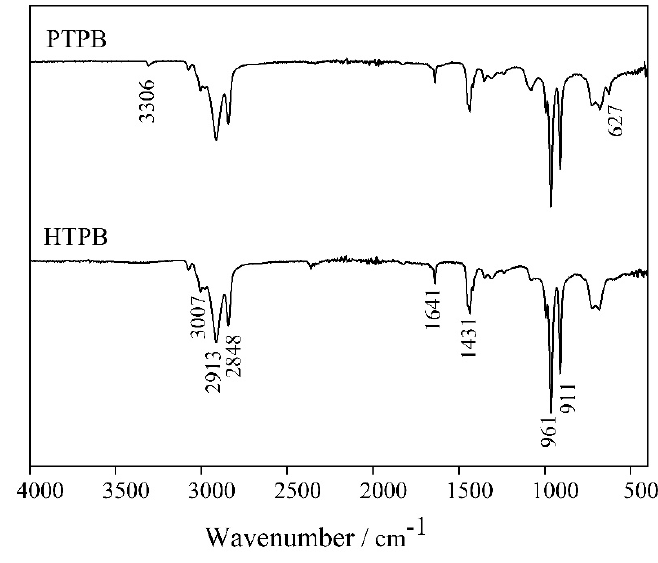
Figure 1. FTIR spectra for HTPB and PTPB.